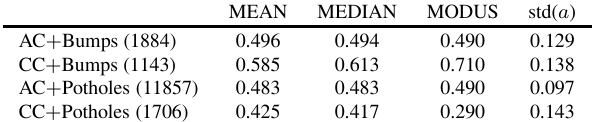
Table 3 Statistics of extreme values positions a on the l N axis